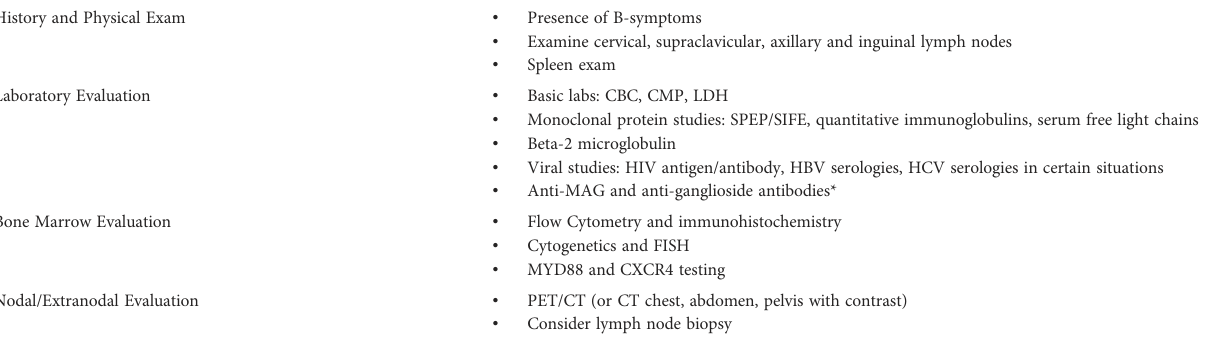
TABLE 2 Lymphoma Evaluation for Patients with IgM AL